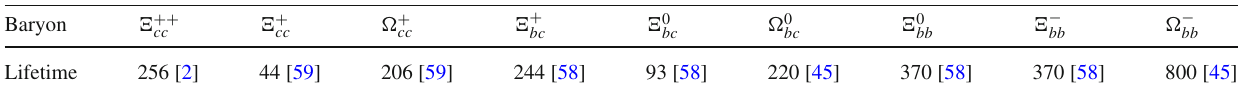
region in Fig. 8, and when Eq. (35) is used, the value evaluated at the midpoint of the line segment in Fig. 8 is shown. The process